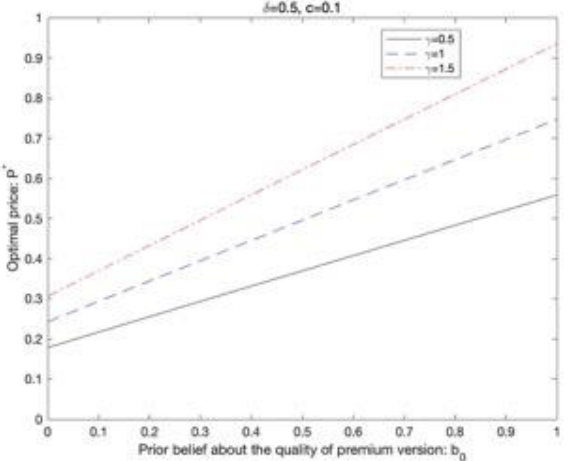
Figure 3. The impact of prior beliefs 𝑏 0 on pricing strategies.